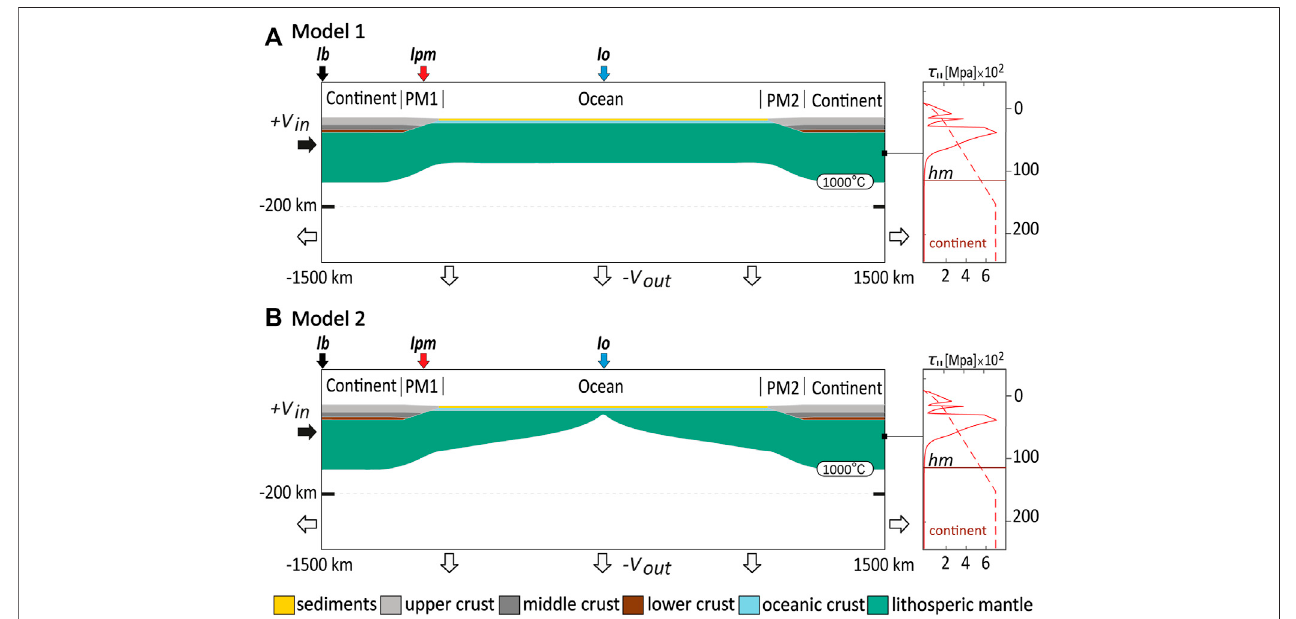
FIGURE2| Modelsetupfor (A) auniformthicknessofoceaniclithosphere;and (B) amodelincorporating amid-oceanicridge. + V in isthevelocityappliedattheleft model boundary and − V out theout fl ow. Ib , Ipm and Io are theintegratedstressat themodel boundary, passivemargin, and oceanic basin, respectively. Rightdiagrams are the strength envelopes for the continent, calculated with the second invariant of the deviatoric stress tensor and thermal gradient. hm is the mechanical base of the lithosphere.